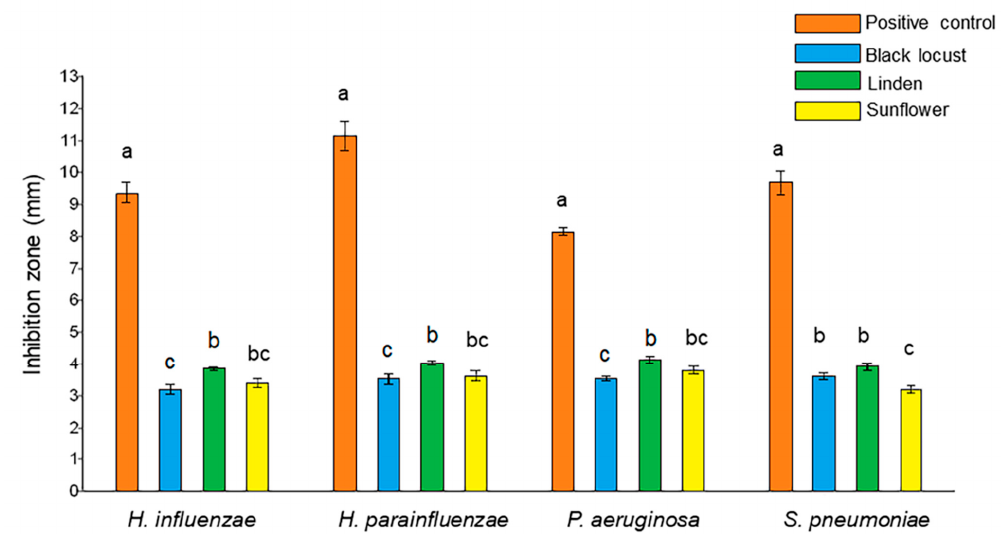
Figure 3. Antibacterial activity of black locust, linden, and sunflower honey samples against respiratory tract bacteria. The diameter of the inhibition zones was expressed in mm. Positive controls: gentamicin against P. aeruginosa , ceftriaxone against Haemophilus spp., and S. pneumoniae . Different letters above bars representing the same bacterial strain indicate significant differences at p ≤ 0.05.